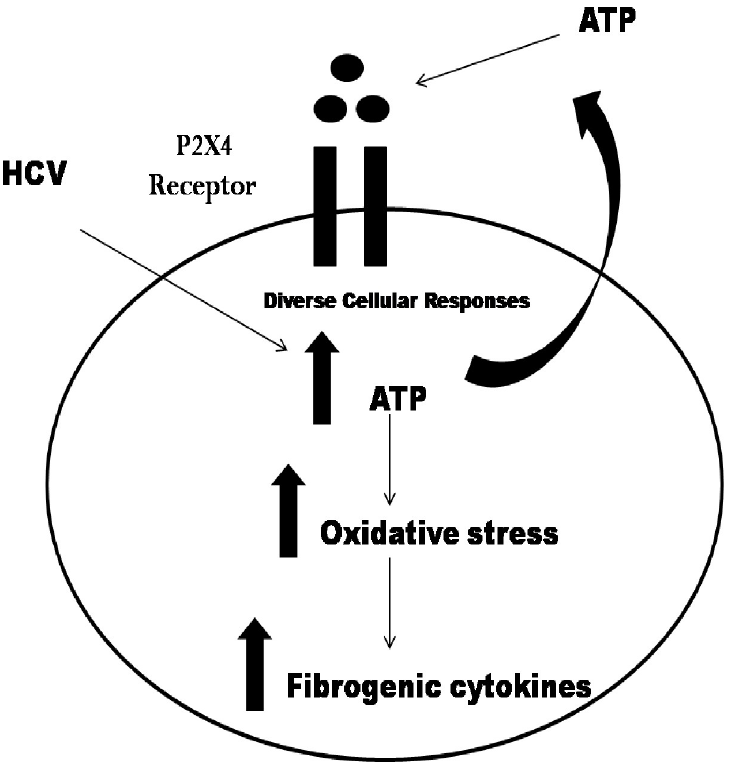
Fig 19. Schematic overview of the purinergic signaling in the presence of HCV. HCV interrupts purinergic signaling Increased ATP in the extracellular mileu increases oxidative stress and fibrogenic cytokines and ECM cytokines leading towards